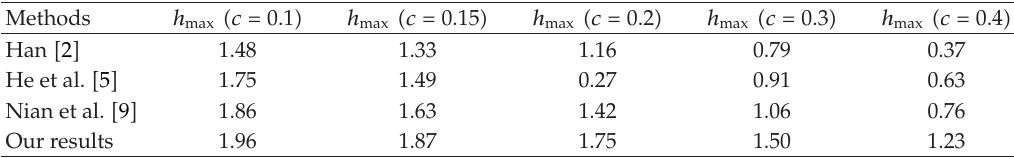
Table 3: Comparison of the maximum allowed time delay h